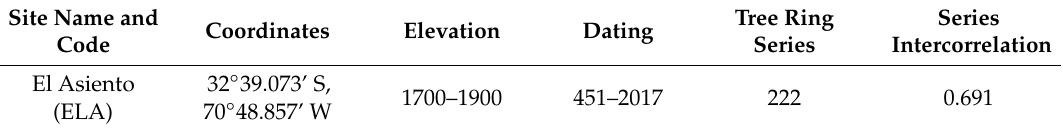
Table 1. Characteristics of the tree-ring data used for the Petorca basin streamflow